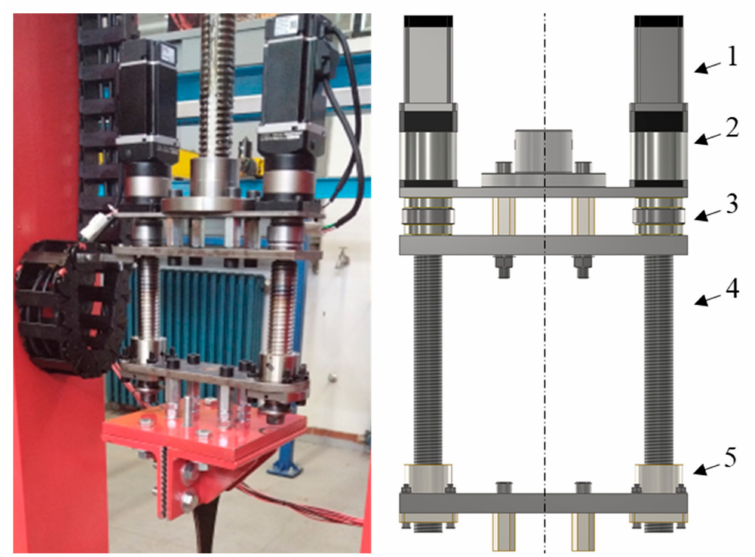
Figure 4. Fatigue testing module: servo motor (1), planetary gearbox (2), bearing (3), threaded spindle (4), nut with roller balls for the threaded spindle